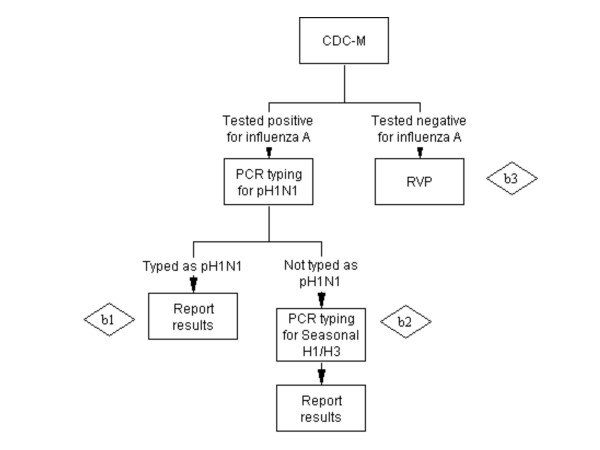
Scenario B - CDC-M with/without RVP.